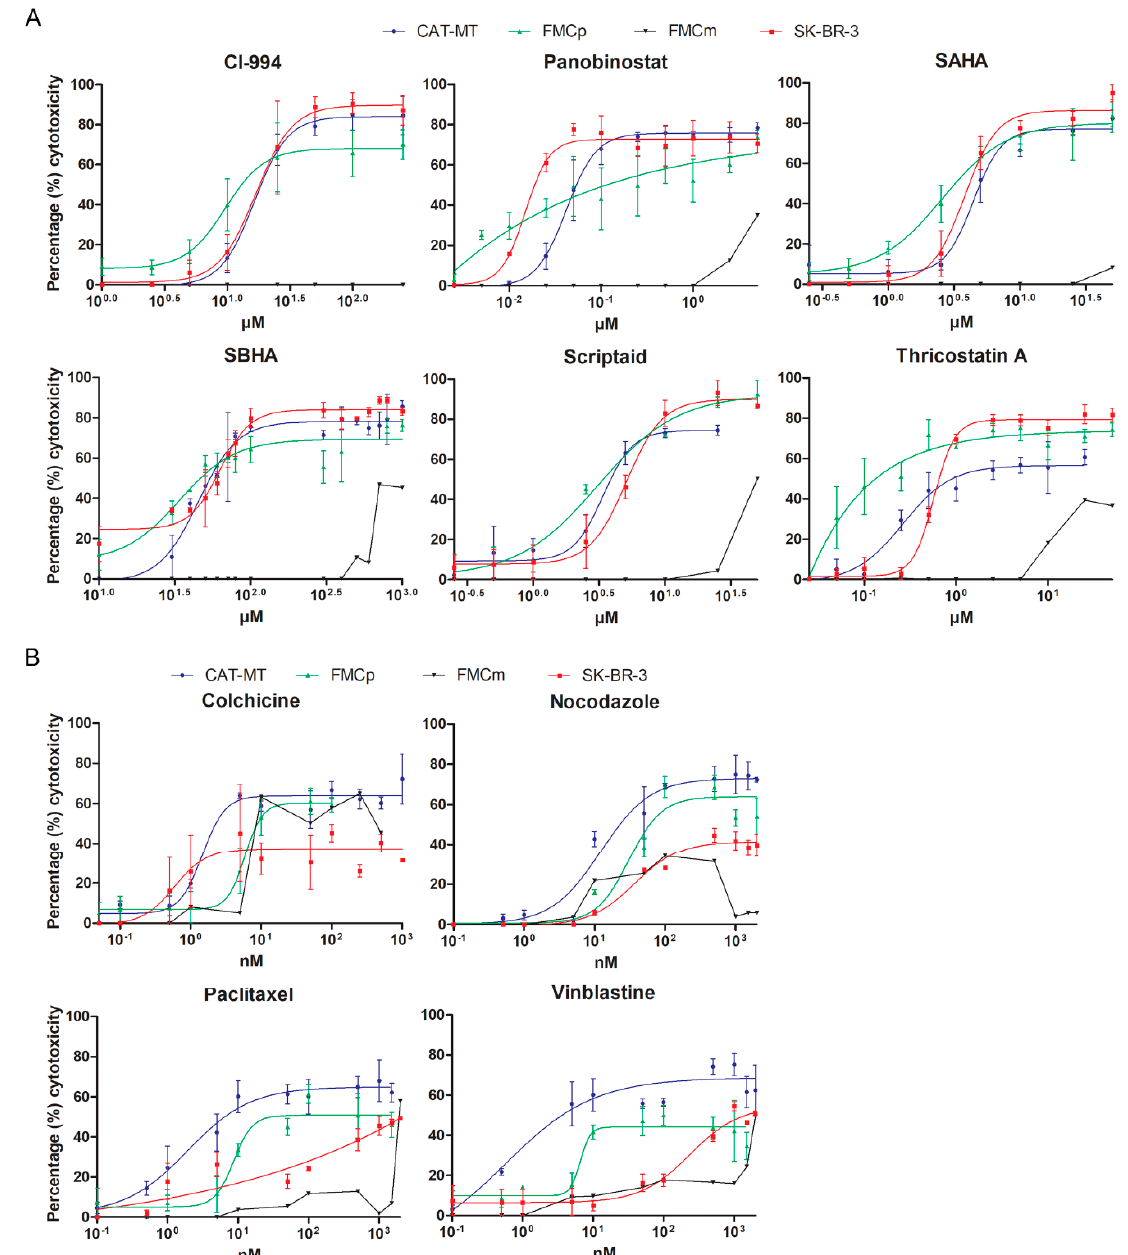
Figure 2. Histone deacetylases inhibitors (HDACis) and microtubules inhibitors (MTIs) present cytotoxicity effect on feline cell lines CAT-MT and FMCp. The feline cell lines (CAT-MT, FMCp, and FMCm) and the human breast cancer cell line SK-BR-3 were incubated with increasing concentrations of ( A ) HDACis (CI-994, panobinostat, SAHA, SBHA, scriptaid, and trichostatin A and ( B ) MTIs (colchicine, nocodazole, paclitaxel, and vinblastine). After 72 h, cell viability was measured using WST-1 (abcam). The log (inhibitor) vs response (variable slope) function in Graph Pad Prism (version 5.00 for Windows®, GraphPad Software, CA, USA) used to calculate the IC50 value is shown for CAT-MT, FMCp, and SK-BR-3 cell lines. Data was not sufficient to calculate IC50 values for FMCm cell line. DMSO (CI-994, panobinostat, SBHA, SAHA, scriptaid, trichostatin A, nocodazole, paclitaxel, and vinblastine) and ethanol (colchicine) were used as vehicle control.